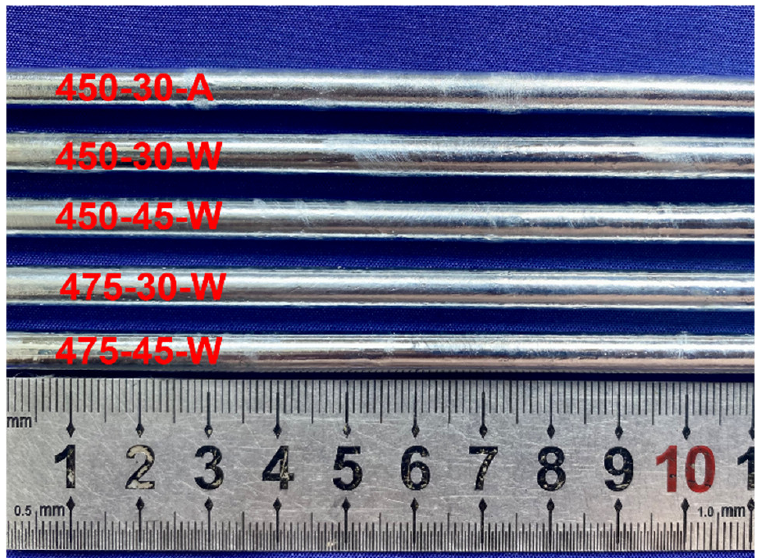
Figure 1. Comparison of macroscopic morphology of Zn-10Al-0.08MM hot dip coated steel wire under different processes.